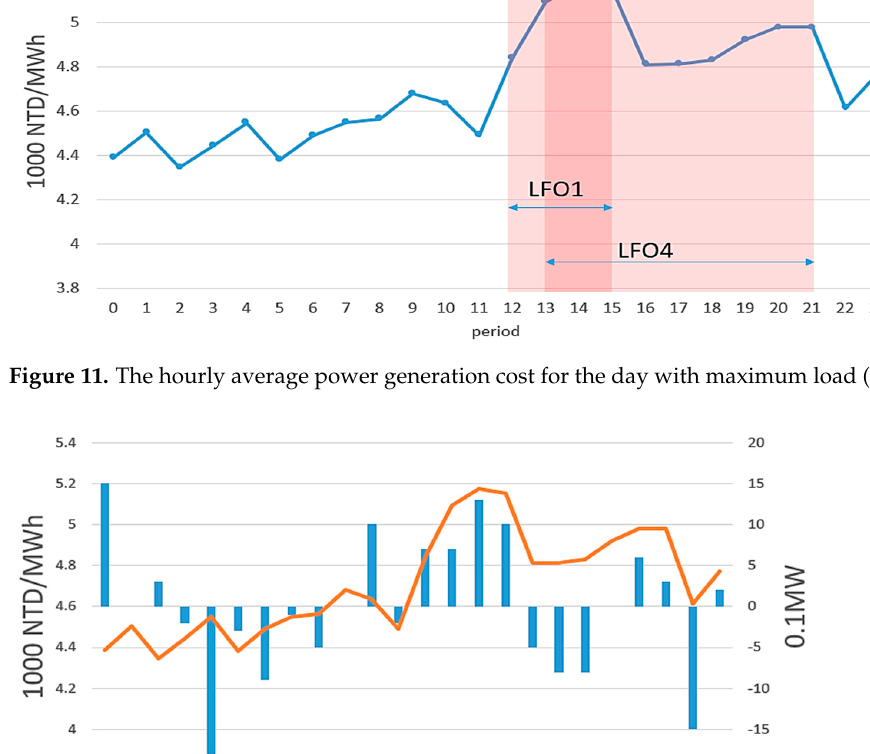
Figure 10. The operating reserve and load for the day with maximum load (case 2).